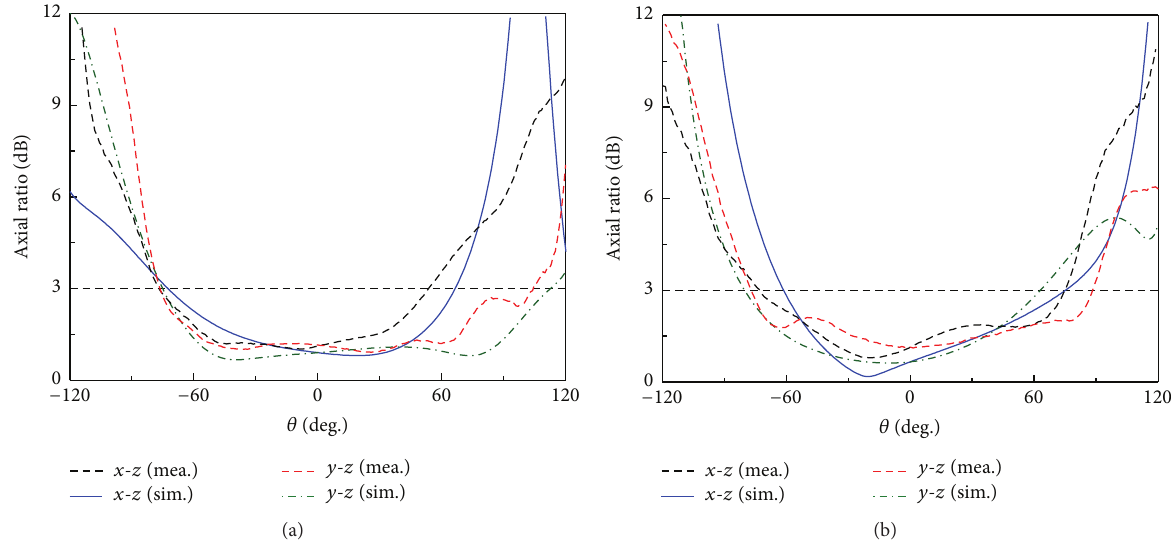
Figure 13: Axial ratio as a function of theta angle: (a) GPS L1 and (b) GPS L2 frequencies.